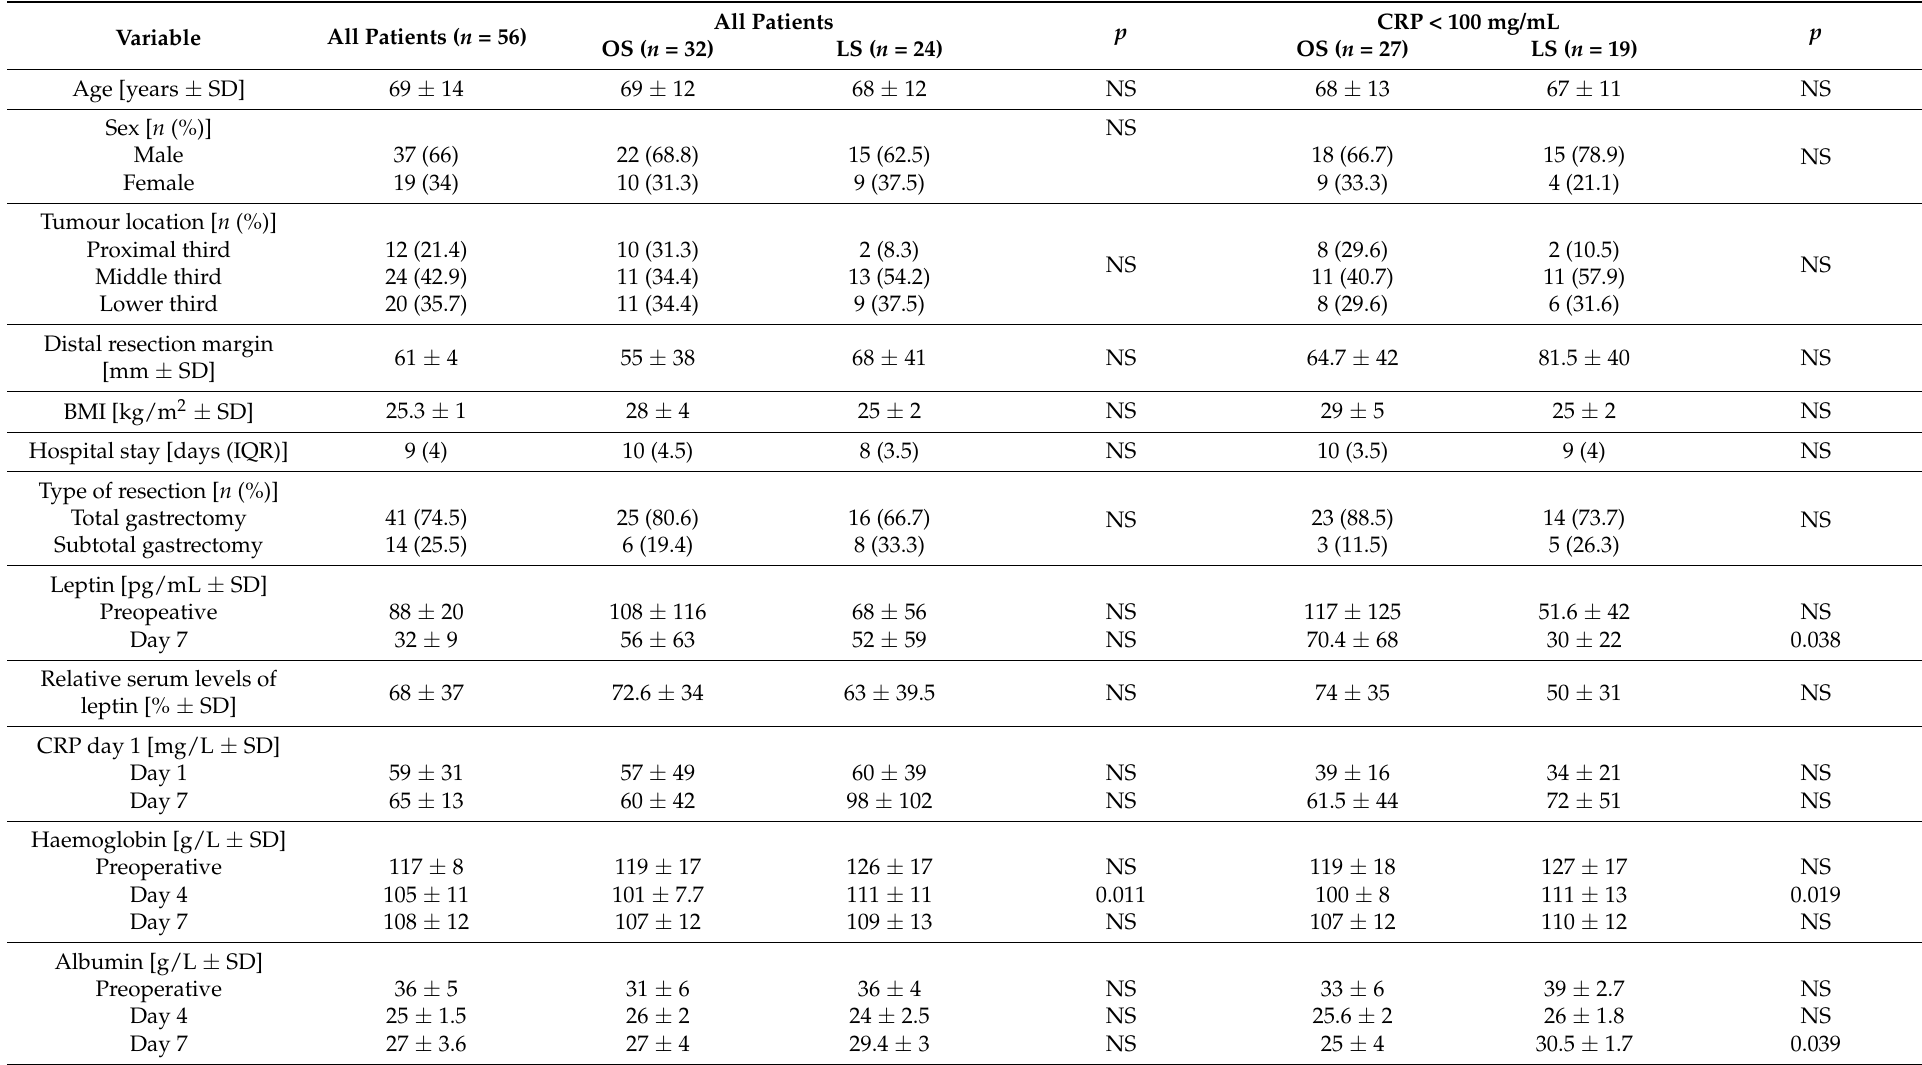
Table 1. Clinicopathological